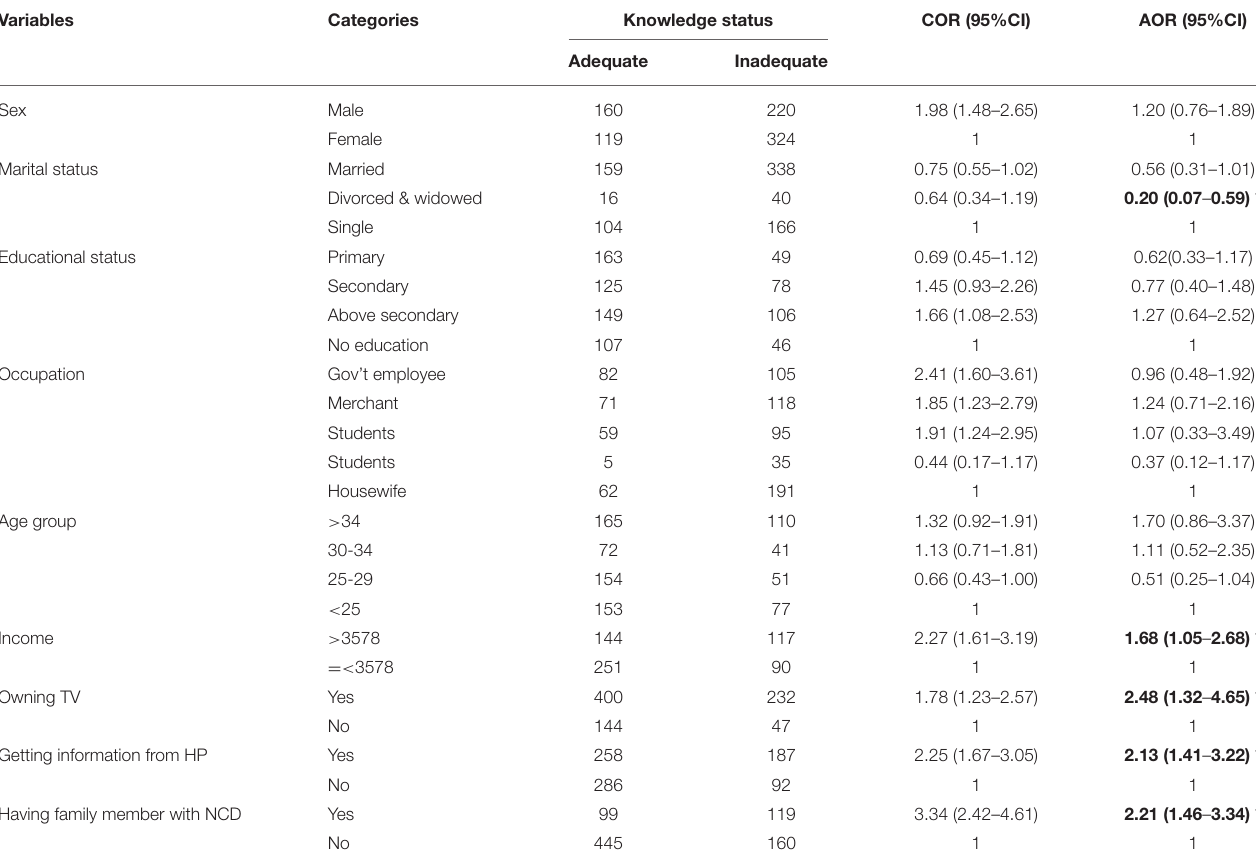
TABLE 3 | Factors associated with knowledge of NCDs among adult residents of selected towns of north Shewa zone, Oromia region, central Ethiopia, 2021.